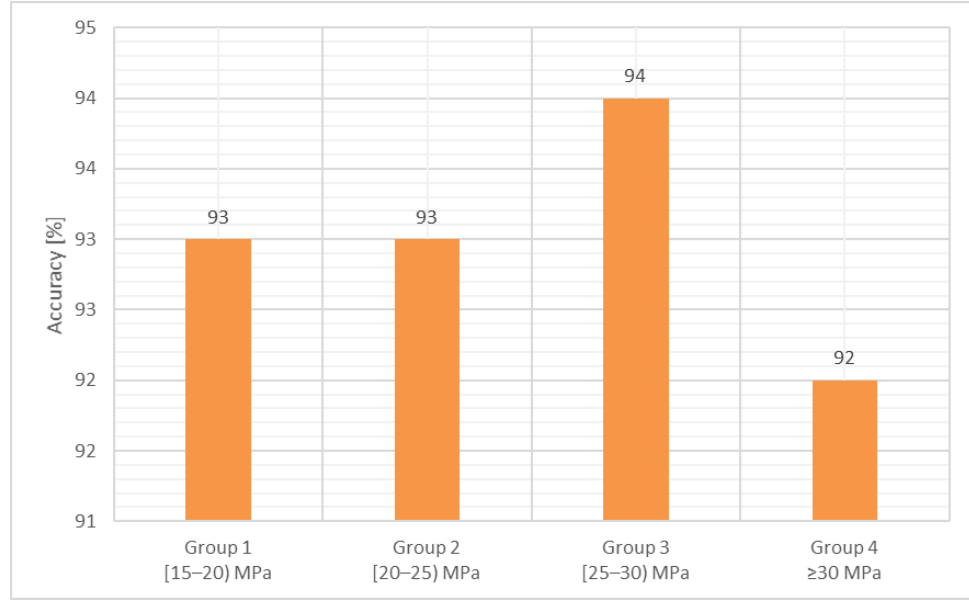
Figure 6. Compressive strength, mean values.